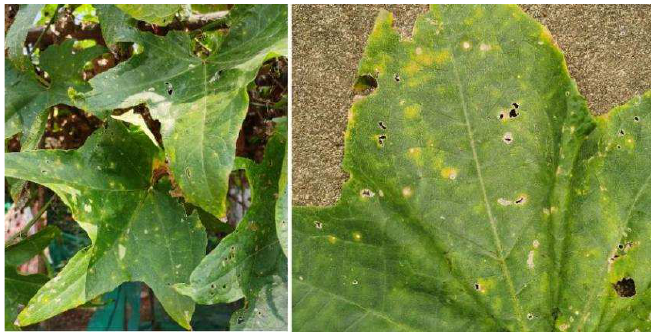
Figure 1. Symptoms of the diseased luffa sponge gourd leaves in field.